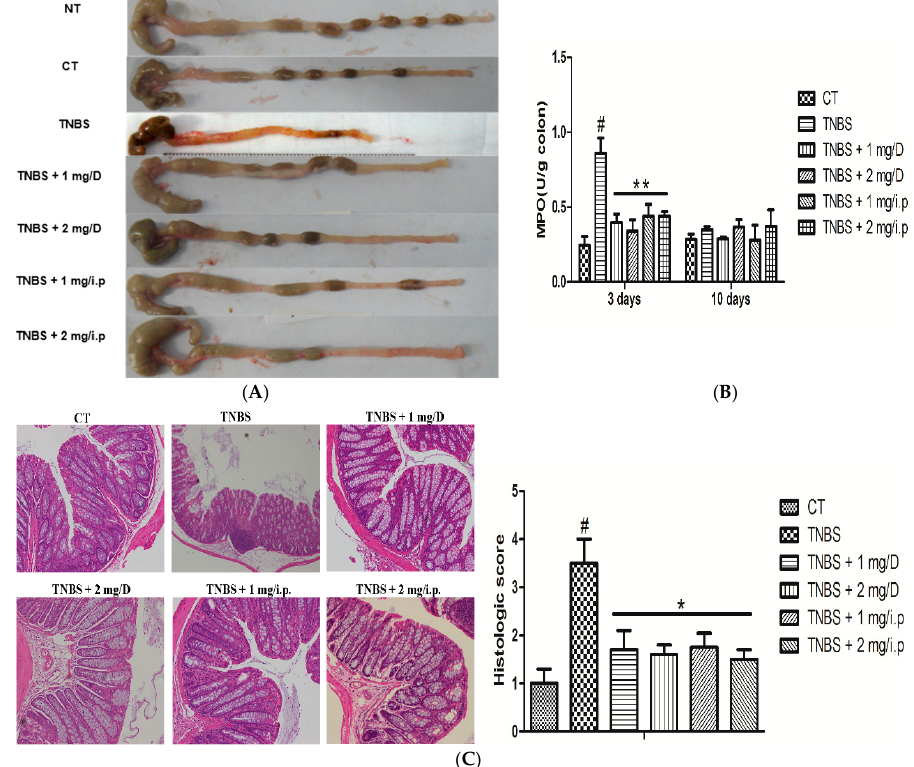
Figure 2. Effects of MMF treatment on the development of TNBS-induced acute colitis in mice.